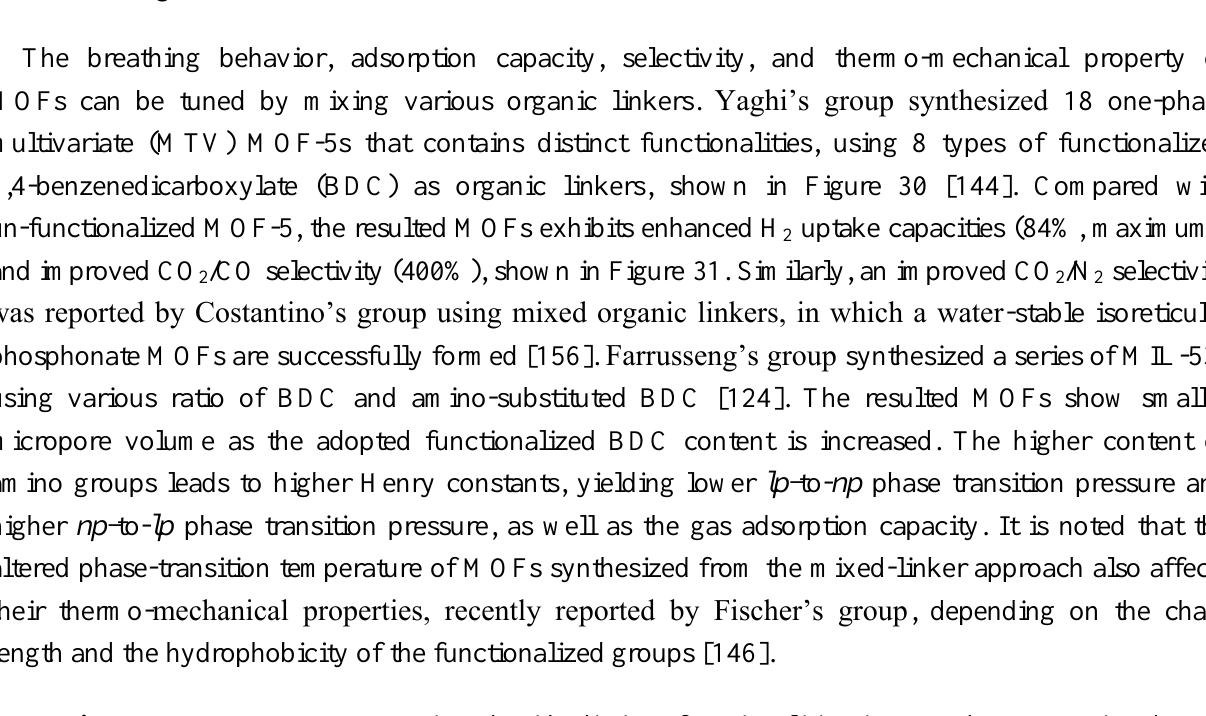
Figure 30. MTV-MOF-5 equipped with distinct functionalities in one phase. Reprinted with permission from [144]. Copyright 2010, American Association for the Advancement of